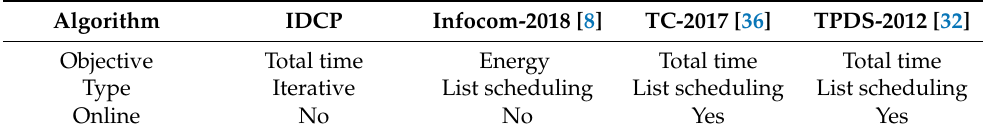
Table 1 lists the four algorithms evaluated in our simulations. Table 1. Comparison of the algorithms evaluated.